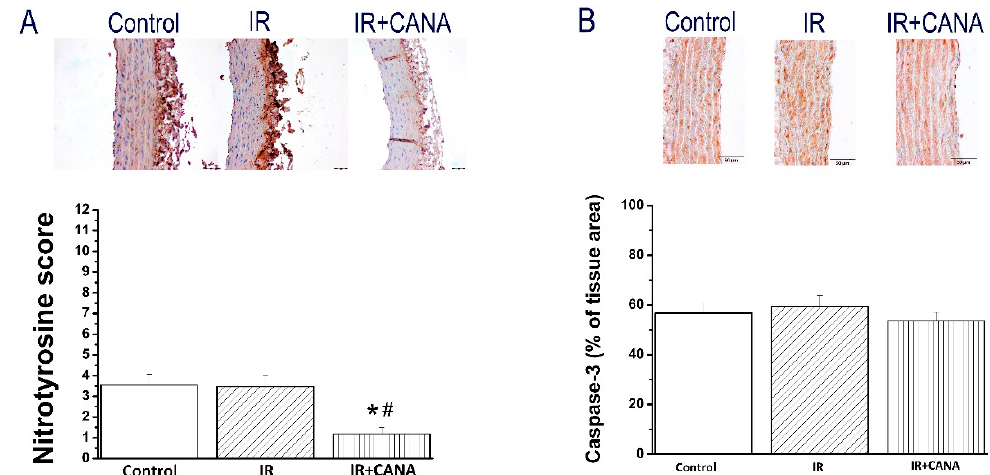
Figure 5. Effect of canagliflozin (CANA) on aortic nitrotyrosine and caspase-3 expression after vascular ischemia/reperfusion (IR) injury. ( A ) Semiquantitative scoring of nitrotyrosine and ( B ) quantitative analysis of caspase-3 immunohistochemical staining with representative micrographs (scale: 50 µm). Results are represented as mean ± SEM. * p < 0.05 versus Control; # p < 0.05 versus IR. n = 32–44 aortic rings from 8–11 rats.